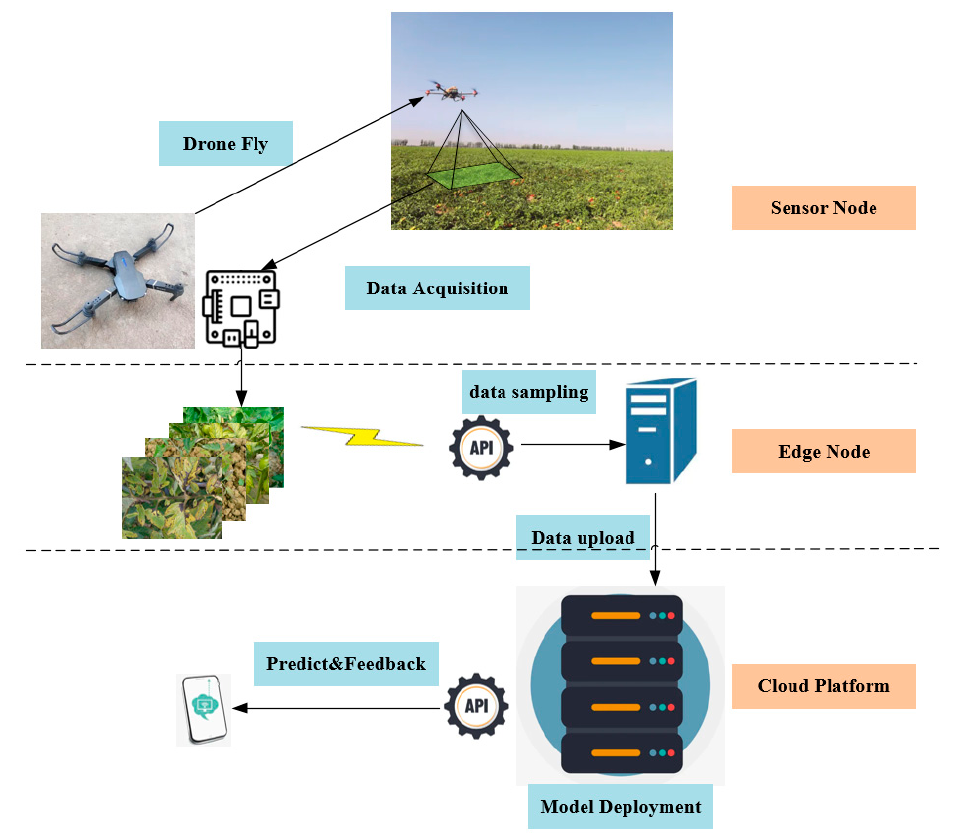
Figure 2. The monitoring agriculture scenario for tomato plants.